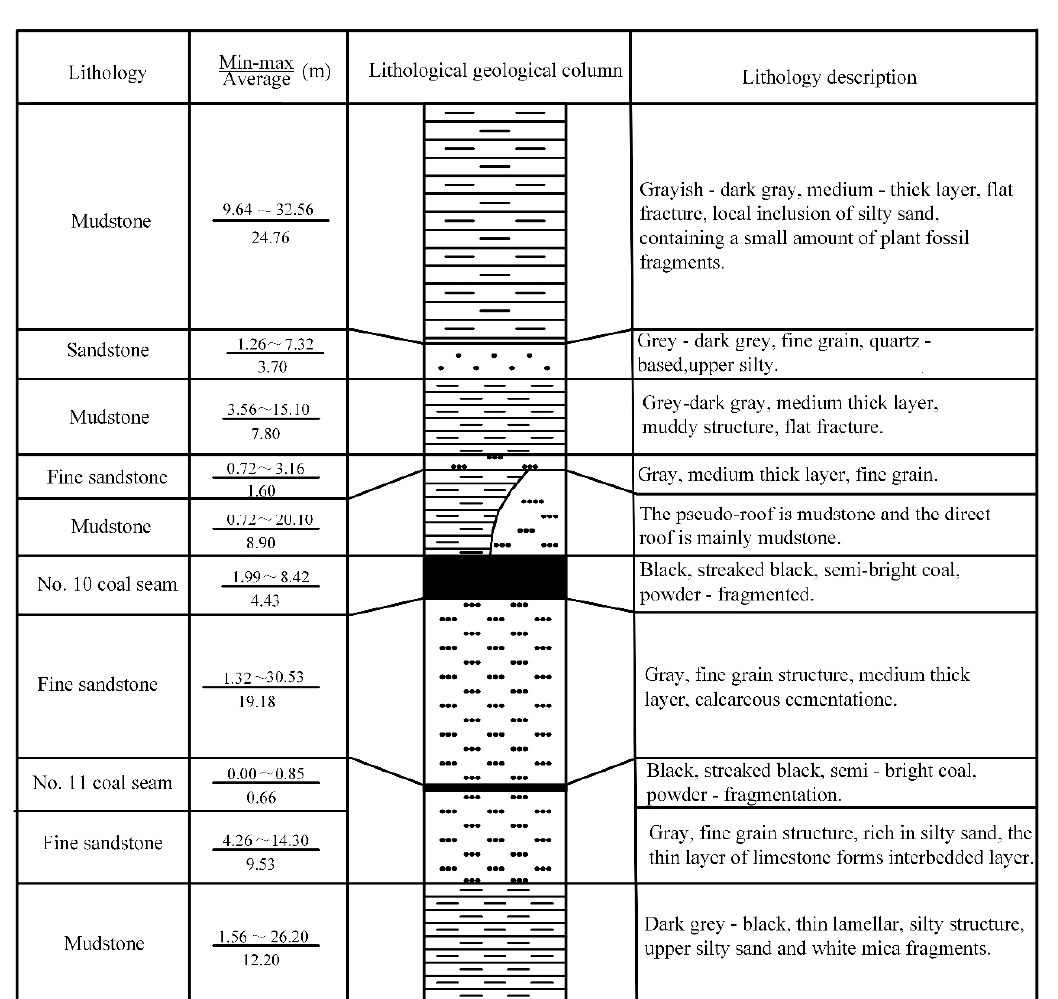
Figure 1. Simplified map of Yuandian no.2 coal mine and layout of the test roadway.